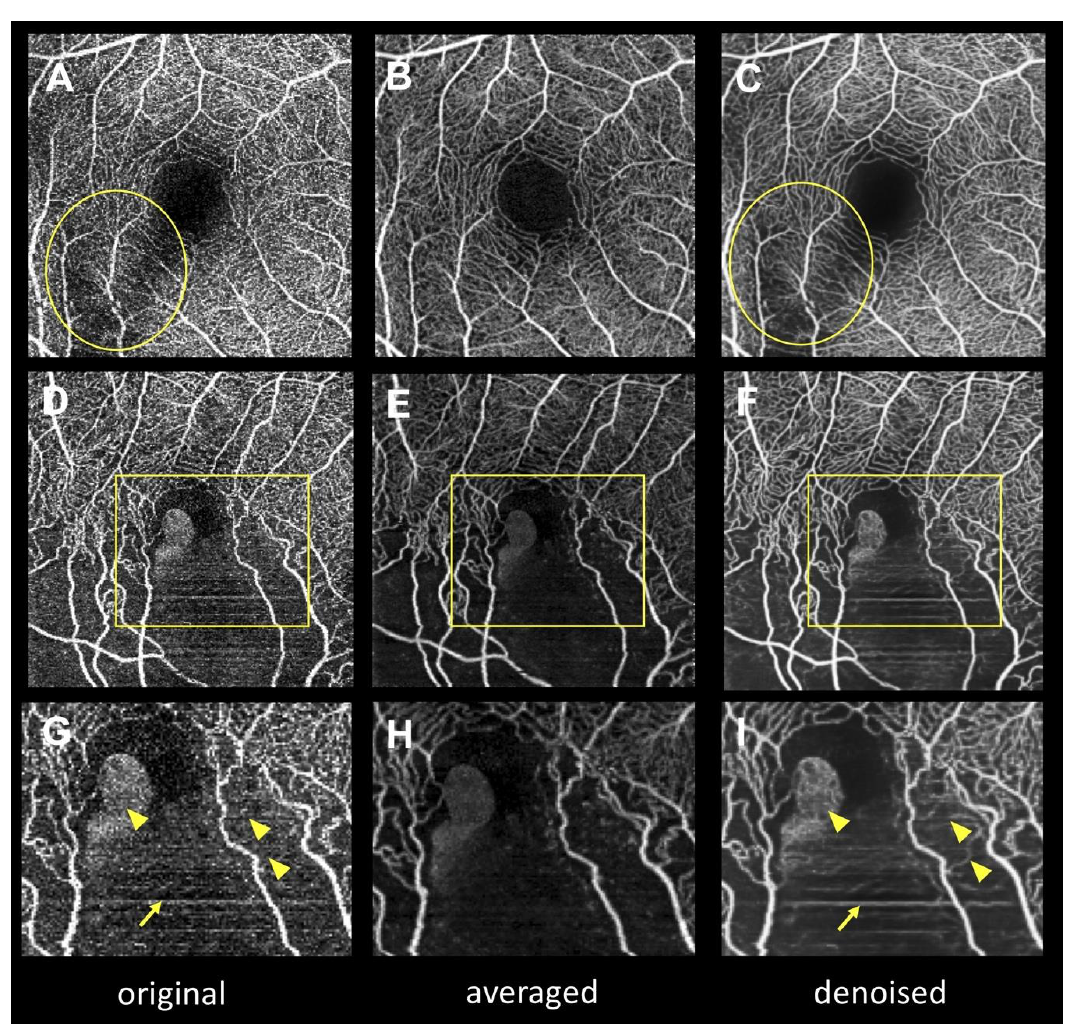
Figure 4. Deep learning-derived artifacts in denoised images. ( A , D , G ), Original images. ( B , E , H ), Averaged images. ( C , F , I ), Denoised images. G–I, Magnified images of open squares in D–F. In the original image in A, signal attenuation is evident in the parafoveal area (open circle) due to media opacity. Capillary over-dropped out artifacts appear in the denoised image in C, which were obtained by applying deep learning denoising. On the other hand, the averaged image in B does not exhibit excessive signal attenuation. Motion artifacts (arrows) and noise accumulation (arrowheads) appear in the original image in G. In the denoised image in I, the motion artifacts appear emphasized (arrow) and the dots have turned into pseudo-vessels due to annealing (arrowheads) (called capillary over-generation), unlike in the averaged image in H.